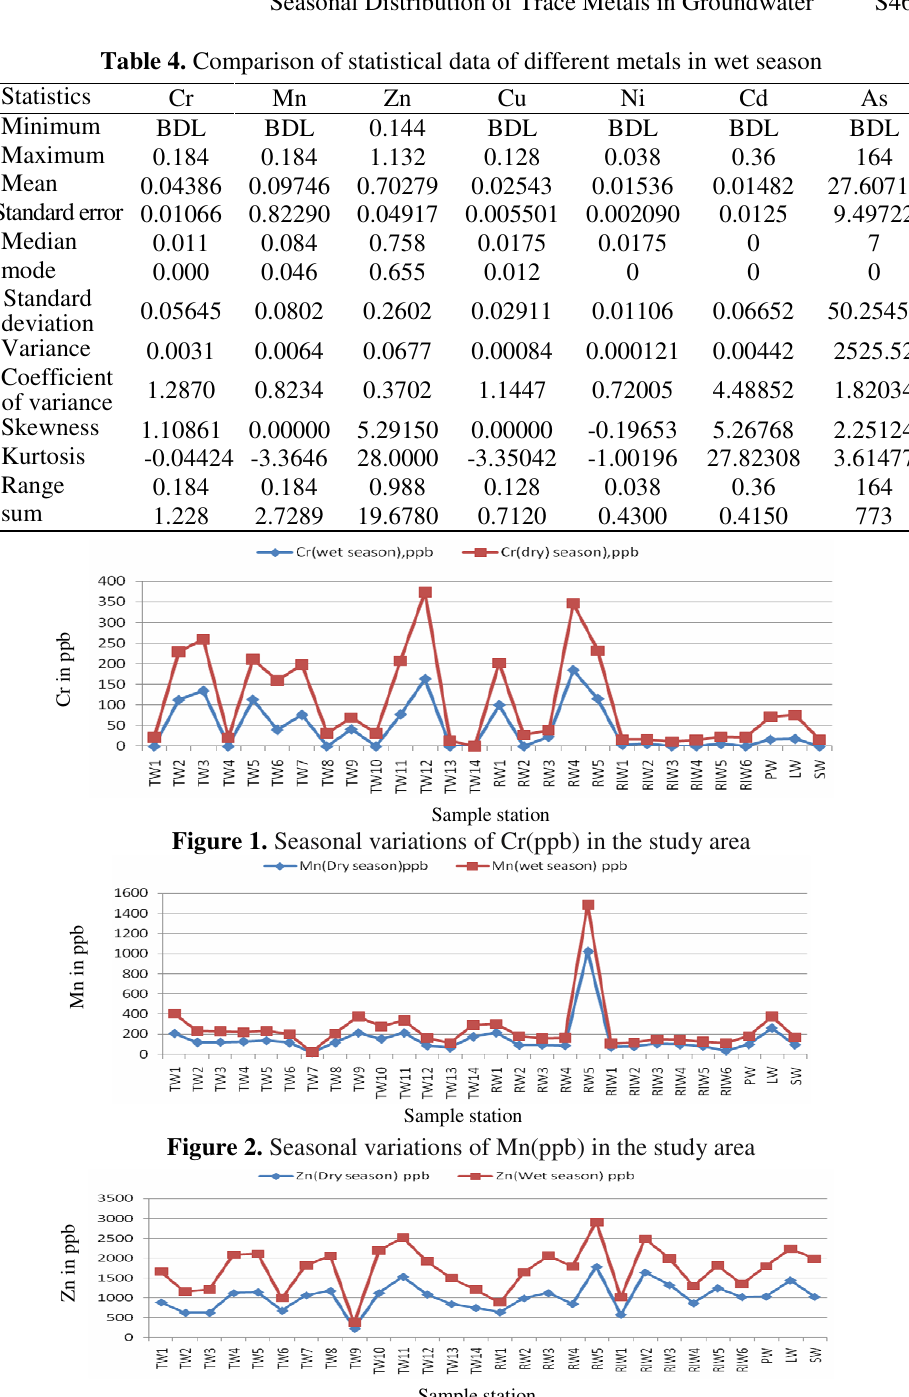
Figure 3. Seasonal variations of Zn(ppb) in the study